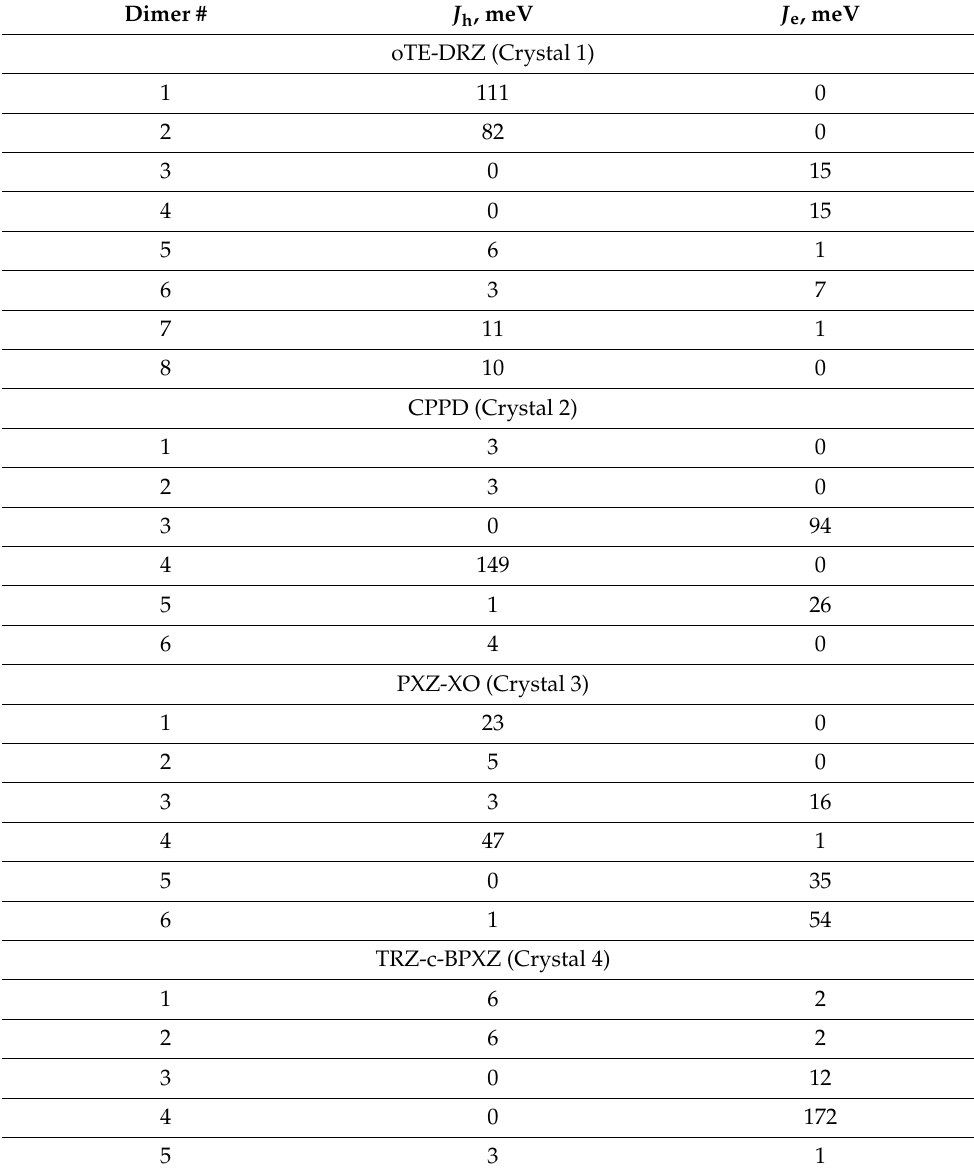
Table 1. Hole ( J h ) and electron ( J e ) transfer integrals for the crystals studied. Dimer # J h , meV J e , meV oTE-DRZ (Crystal